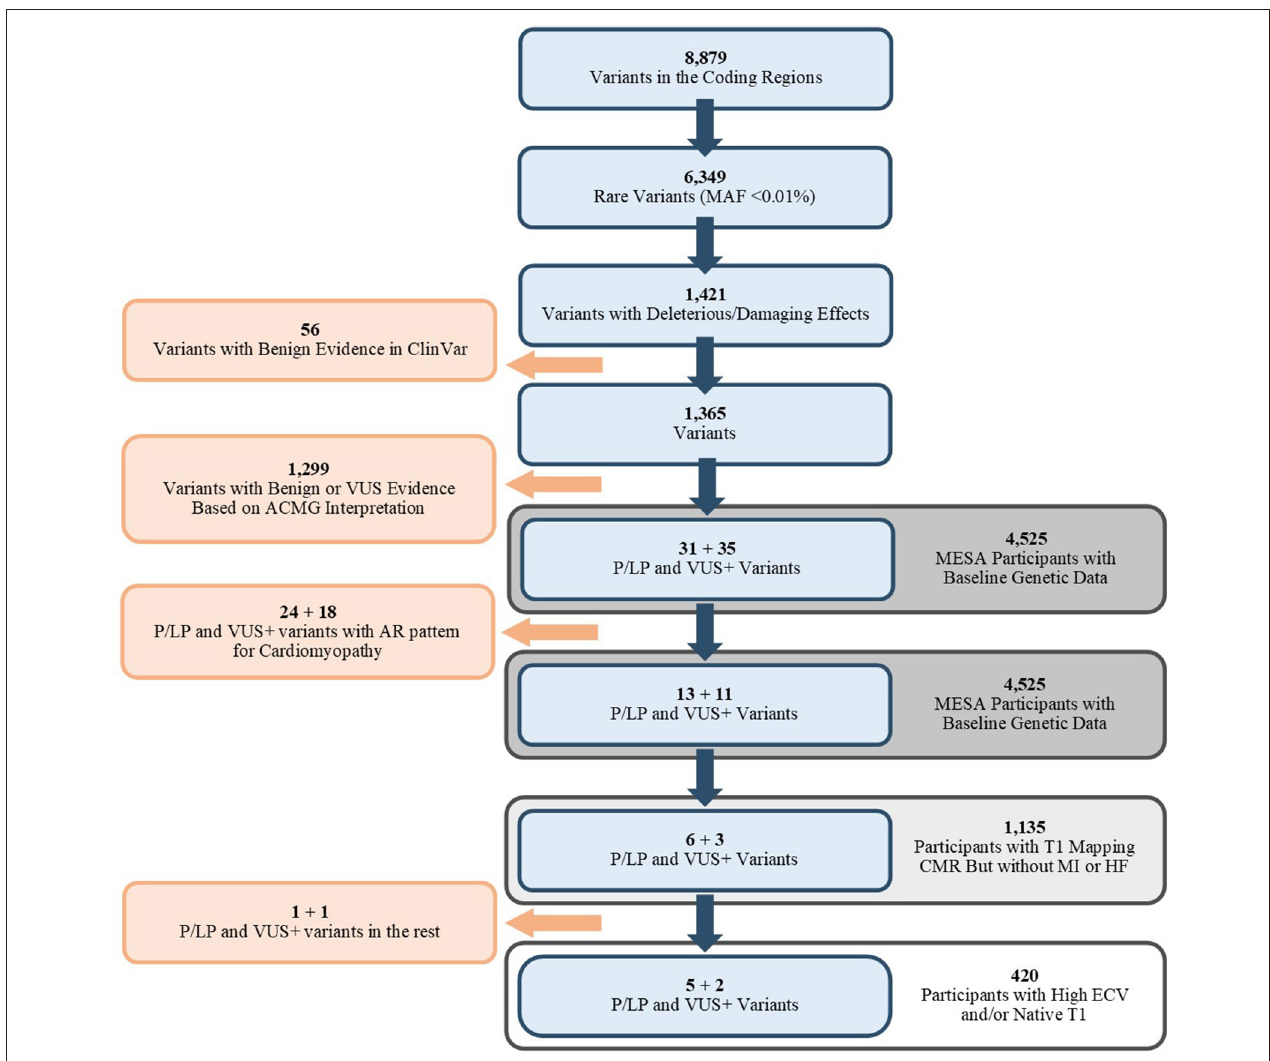
FIGURE 1 | Flowchart of selected variants (Blue) and the associated population. MAF, Mean Allele Frequency; ACMG, American College of Medical Genetics and Genomics; P/LP, Pathogenic/Likely Pathogenic; VUS, Variant of Unknown Significance; VUS + , Variants that were VUS without adjustment of ACMG/AMP criteria; AR, Autosomal Recessive; CMR, Cardiac MRI; MI, Myocardial Infarction; HF, Heart Failure; ECV, Extracellular